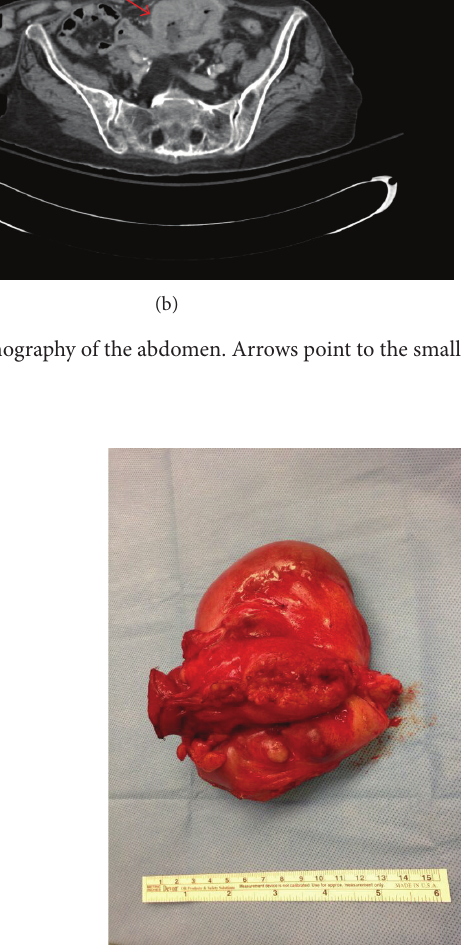
Figure 2: Photograph of the gross resection specimen of the small bowel segment containing